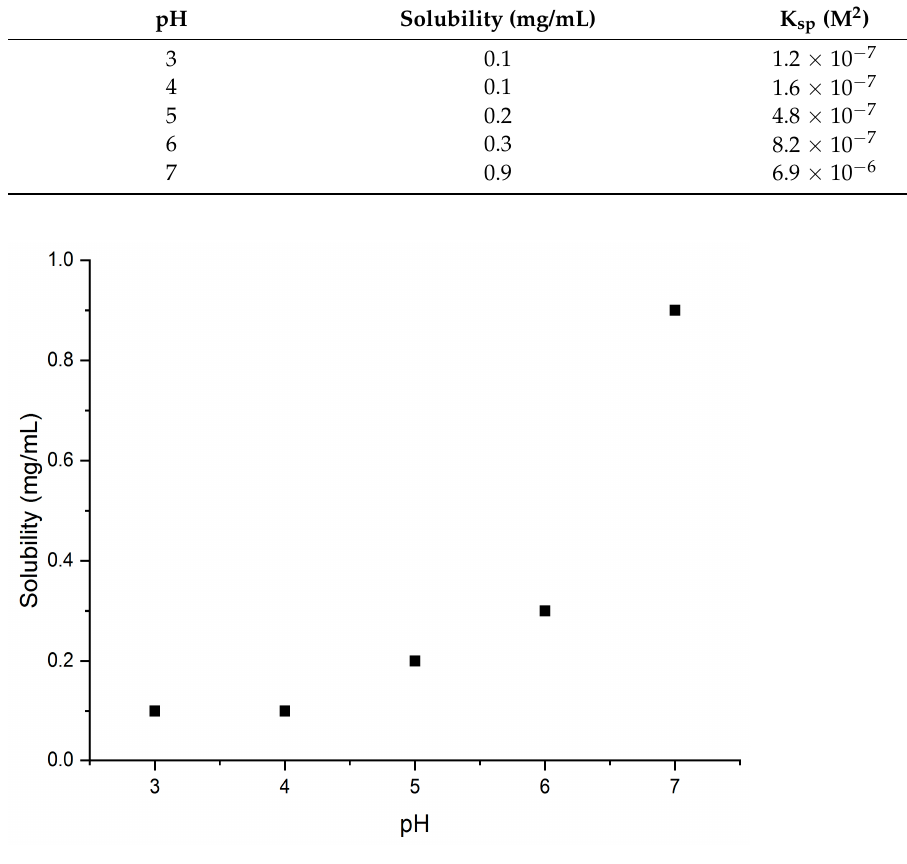
Figure 11. Optic microphotographs of the crystals precipitated from warfarin sodium amorphous buffer solutions at ( A ) pH = 3; and ( B ) pH = 6. 2.8. Dependence of Precipitation on Temperature The effect of temperature on the precipitation of warfarin was investigated. Aqueous solutions of warfarin sodium in amorphous form were prepared and stored at 15, 25, and 35 °C. Apart from a delay in precipitation, no other deviation was observed. 3. Discussion Warfarin sodium is commercially available as an oral suspension. However, analysis of the suspension and the sediment demonstrated that the solid is the unsalted form of warfarin, which is sparingly soluble. Its limited solubility can have an effect on its bioa- vailability. This was the reason why the sodium form was used as API for the formulation in the first place. The analysis of the suspension, supernatant, and sediment showed that precipitation of warfarin occurred without any intermediate stages, i.e., transformation of sodium salt to warfarin. The underlying mechanism relies on the dissociation of the sodium salt in the liquid phase and the subsequent partial protonation of the anion as the pH of the formu- lation was close to the pK of warfarin (5.5). The protonated form, characterized by limited